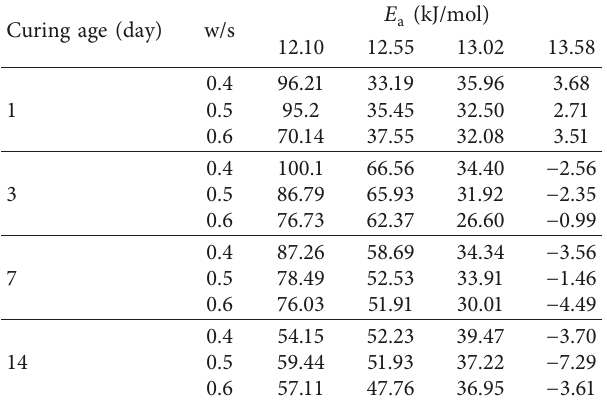
a of slag at different pH